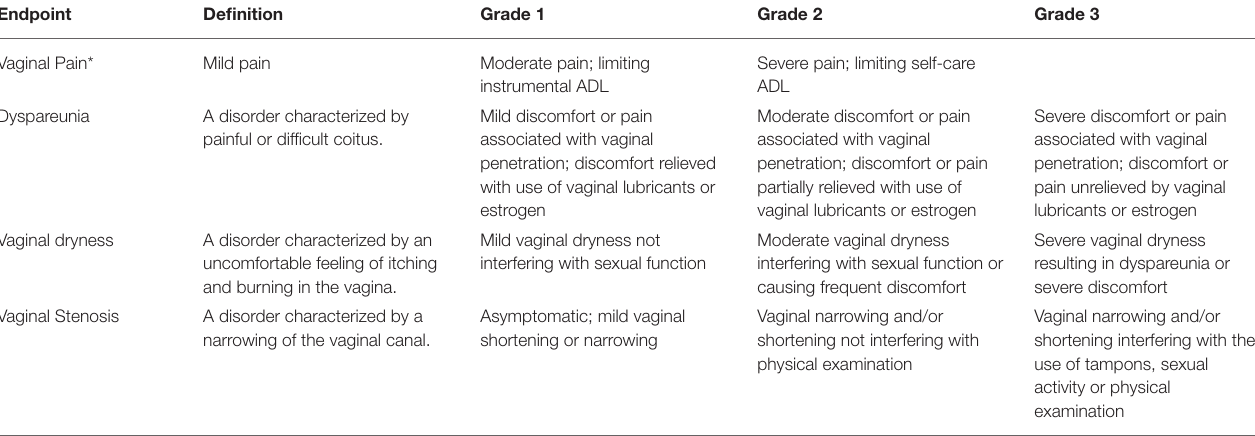
TABLE 1 | Vulvo-vaginal morbidity after radiotherapy: definition and score according to Common Terminology Criteria for Adverse Events (CTCAE) v